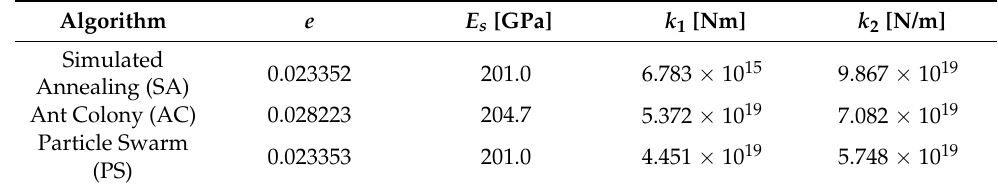
Table 9. Performance of different optimization algorithms for the cantilever beam case. Algorithm